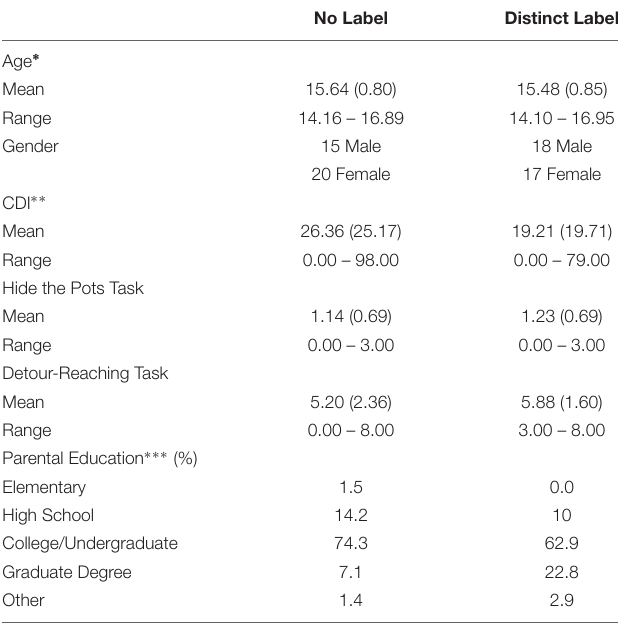
TABLE 1 | Infant age, vocabulary, gender, and parental education as a function of condition. No Label Distinct